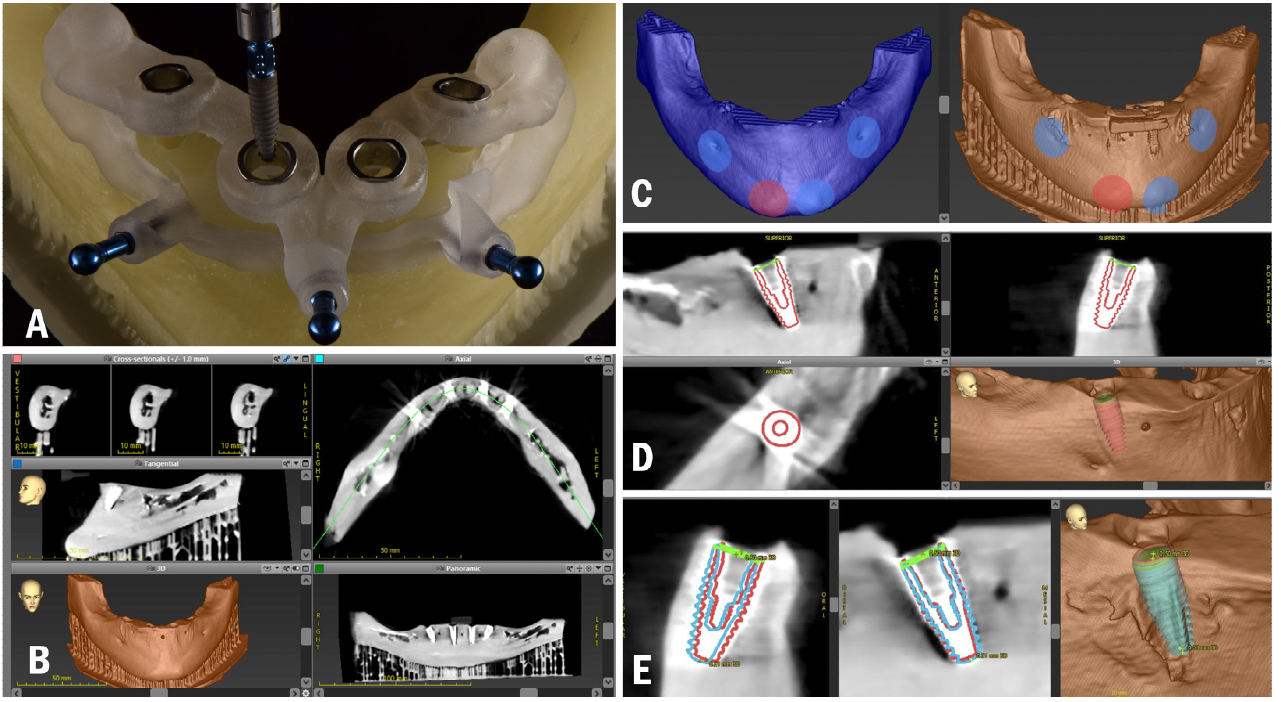
Figure 3. ( A ) In vitro implant placement; ( B ) CBCT of a 3D-printed mandible with inserted implants; ( C ) Planning and 3D-printed model CBCT matching; ( D ) Matching of implants in planning and implants placed in vitro; and ( E )